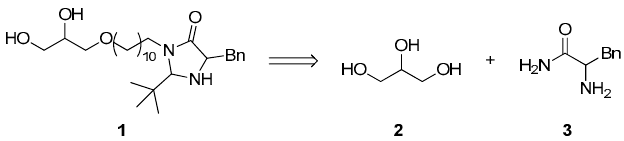
Figure 1. Retrosynthetic pathway of the targeted